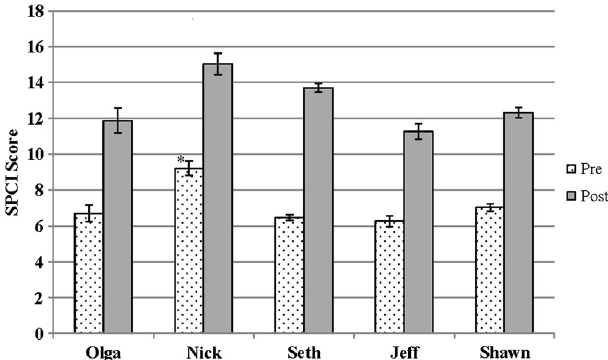
FIG. 1. Mean SPCI scores by instructor. All postscores are significantly greater than prescores ( p < 0 . 001 ). *Nick ’ s mean prescore was significantly greater than all other instructors ’ scores ( p < 0 . 01 ). Bars show standard errors.